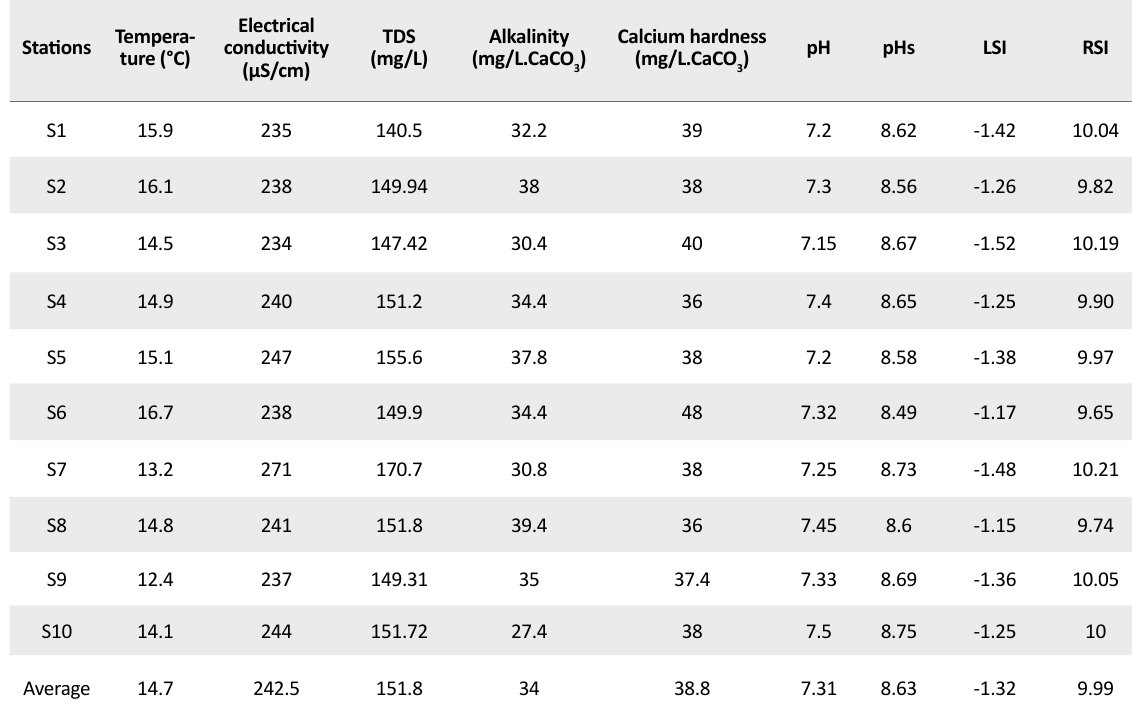
Table 3. Results of chemical analysis of drinking water in Meshginshahr City (first stage of sampling in the Summer)